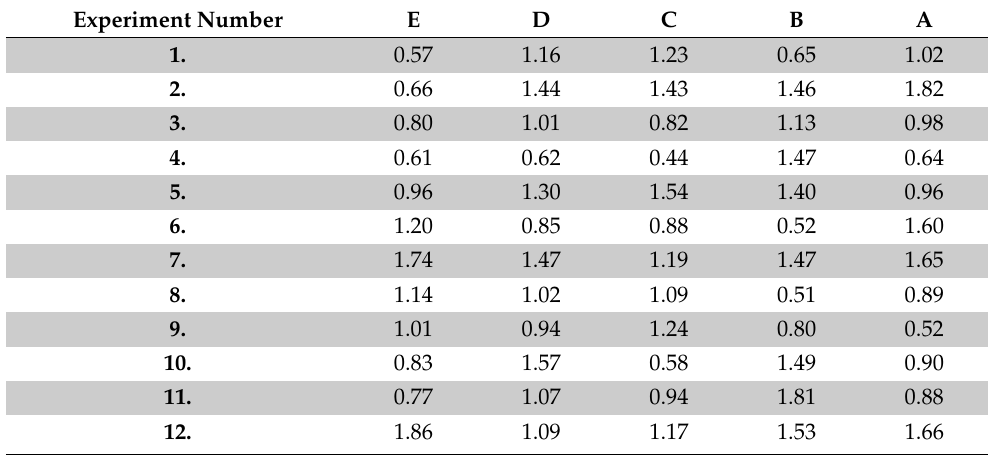
Table 3. The results of the experiments with respect to the parameter X. Experiment